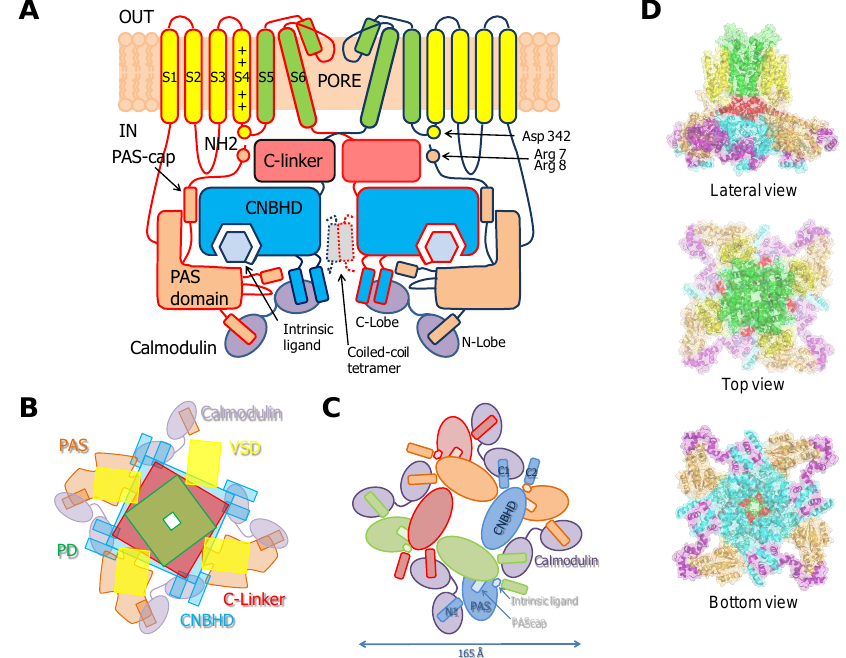
Figure 1. Representation of an Eag1 channel ( A ). Transmembrane regions are in yellow for the Voltage Sensitive Domain (VSD), and green for the Pore Domain (PD). Only two of the four subunits are represented, with a red or blue border. The N-terminal PAS-Cap and Pas domain in orange, the C-linker in red, the CNBHD in cyan, and CaM in purple. The critical Asp 342 in S4 / 5 and Arg 7 and 8 are highlighted. The presumed position of the tetrameric coiled-coil is indicated with dashed lines. ( B ). Realistic representation of the channel views from the top using the same color scheme as in A. ( C ). Realistic representation of a bottom view, excluding the C-linker. Each subunit has a different color. CaM bridges two diametrically opposed subunits. ( D ) Structures visualized using then PDB coordinates (6PBY), rendered with Pymol 1.30 using the same color scheme as in panel A. The initial attempts to localize the sites of interaction identified a region within CNBHD.